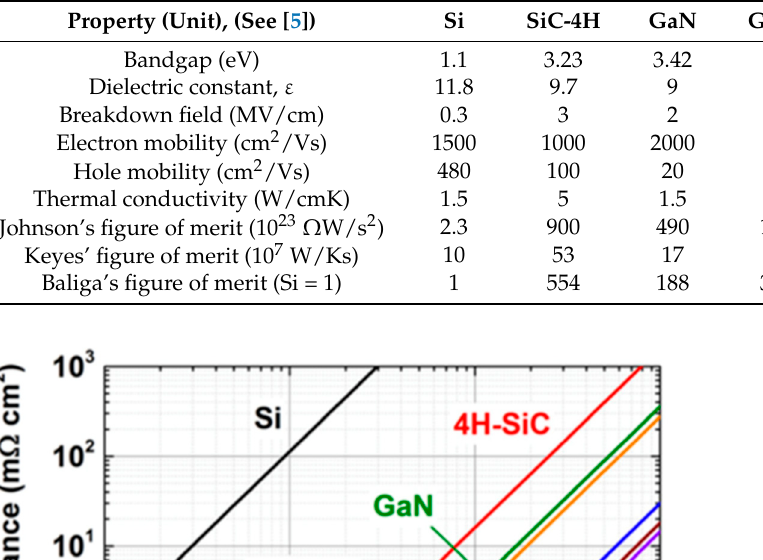
Table 1. Diamond’s properties are strikingly superior to other semiconductors (see [5]) when considered for use in power electronic devices. Johnson’s figure of merit (FoM) is a measure of the ultimate performances of the electronic device at high power and high frequency of a transistor, Keyes’ FoM measures the performance limited by heat generation and removal, and Baliga’s FoM measures performance limited by losses at high-power and high-frequency operation. The properties/figure where diamond is outstanding for the present project are highlighted in orange.